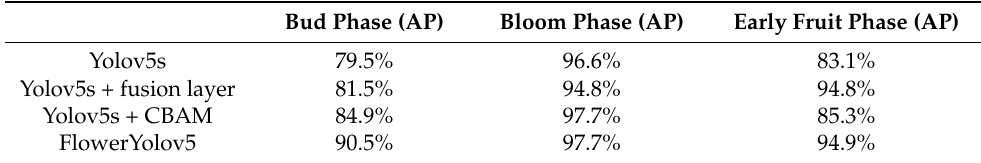
Table 2. Comparison results of model performance using different improvement methods.